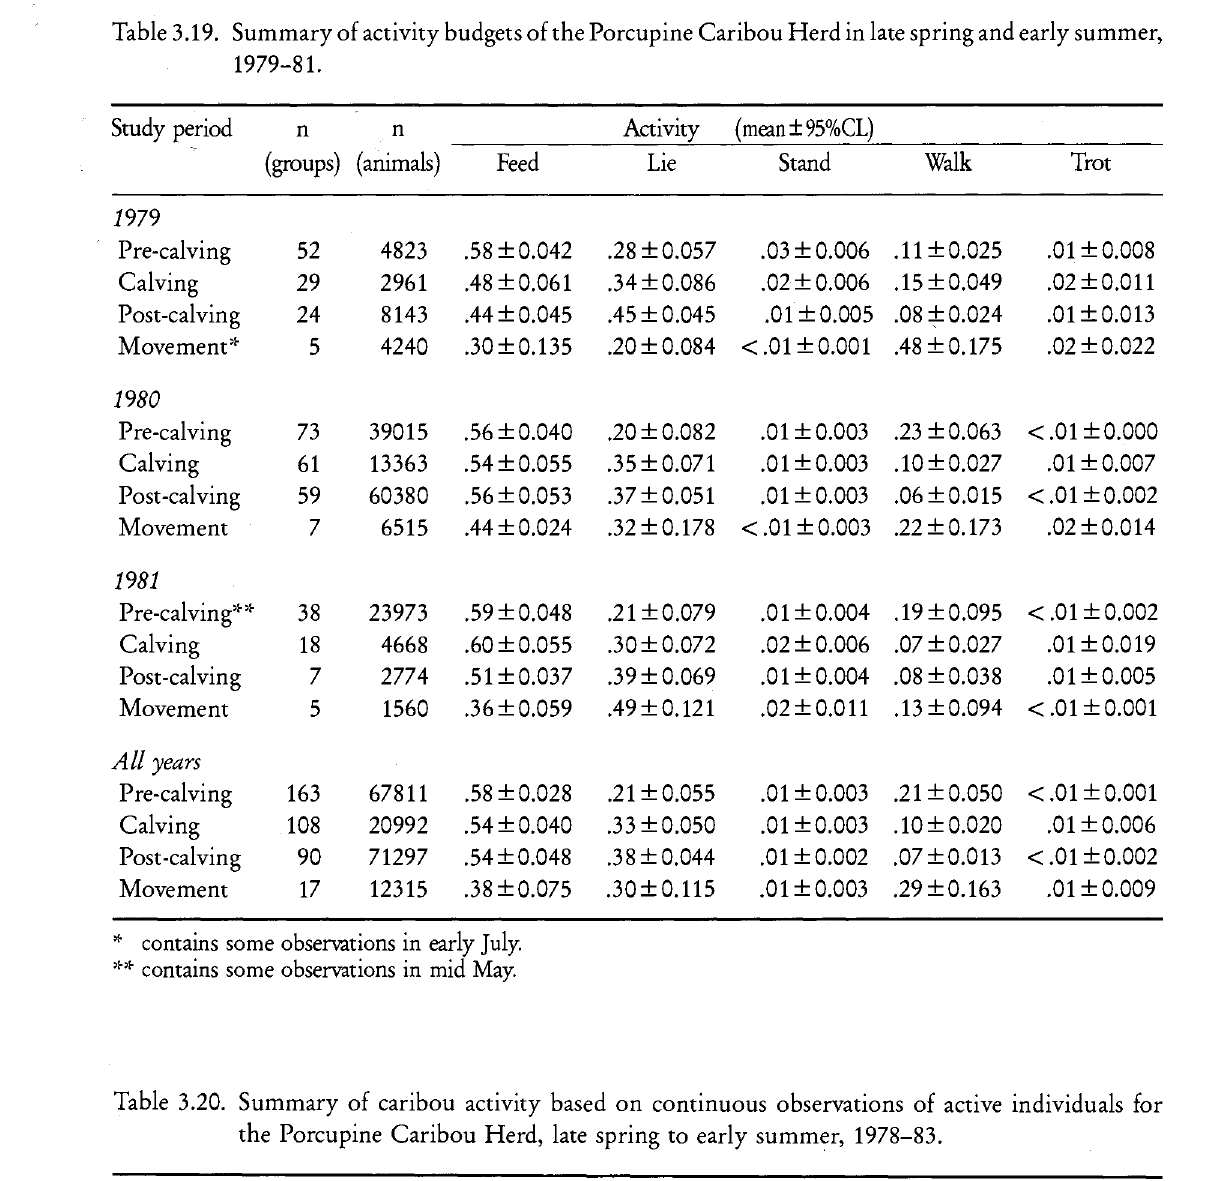
Table 3.19. Summary of activity budgets of the Porcupine Caribou Herd in late spring and early summer, 1979-81.